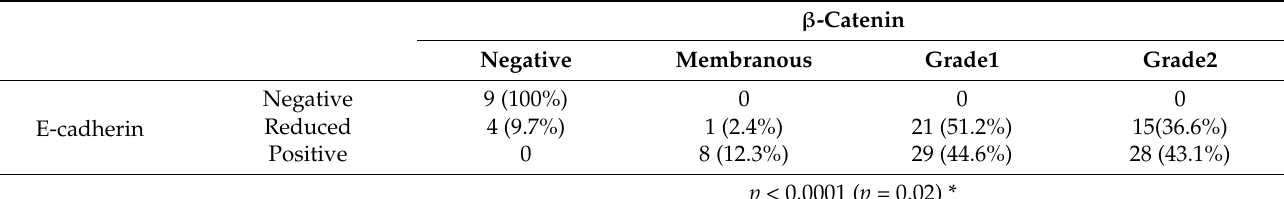
Table 9. Association between the patterns of expression of E-cadherin and β -catenin. β -Catenin Negative Membranous Grade1 Grade2 Negative 9 (100%) 0 0 0 E-cadherin